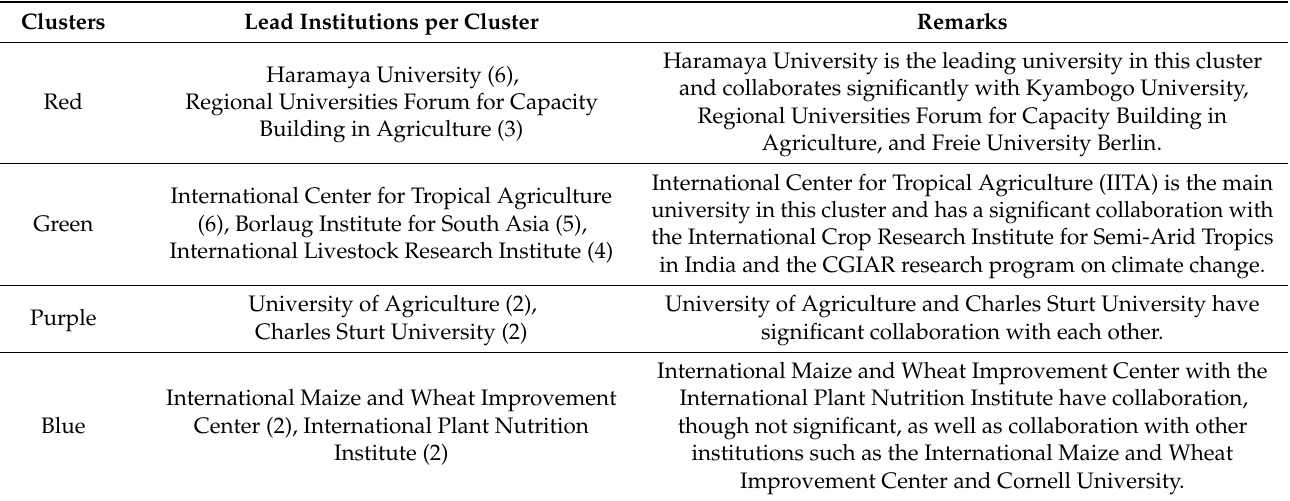
Figure 5. Institution collaboration networks. Table 8. Cluster of institution collaborations around the globe within the period